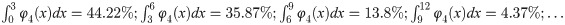
The deployment model by χ ∼ χ2(4) distribution: Assume the network area is divided into 5 parts, S1, S2, …, S5, and n sensors will be deployed into the network.By observing the curve in Fig 4, there are ∫03φ4(x)dx=44.22%;∫36φ4(x)dx=35.87%;∫69φ4(x)dx=13.8%;∫912φ4(x)dx=4.37%;…. The largest number of sensors n × 44.22% can be deployed into the area S1, which is the closest to the sink. The least number of sensors n × 1.27% will be deployed into the area S5, which is the farthest to the sink.